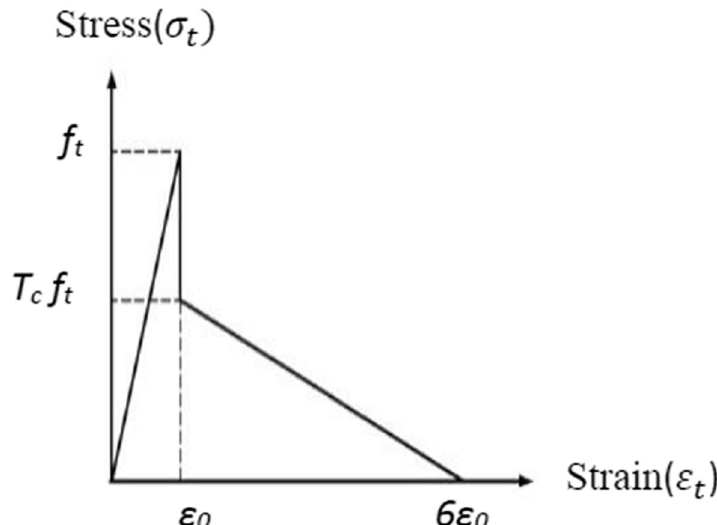
Fig. 14 Stress-strain curve under tension